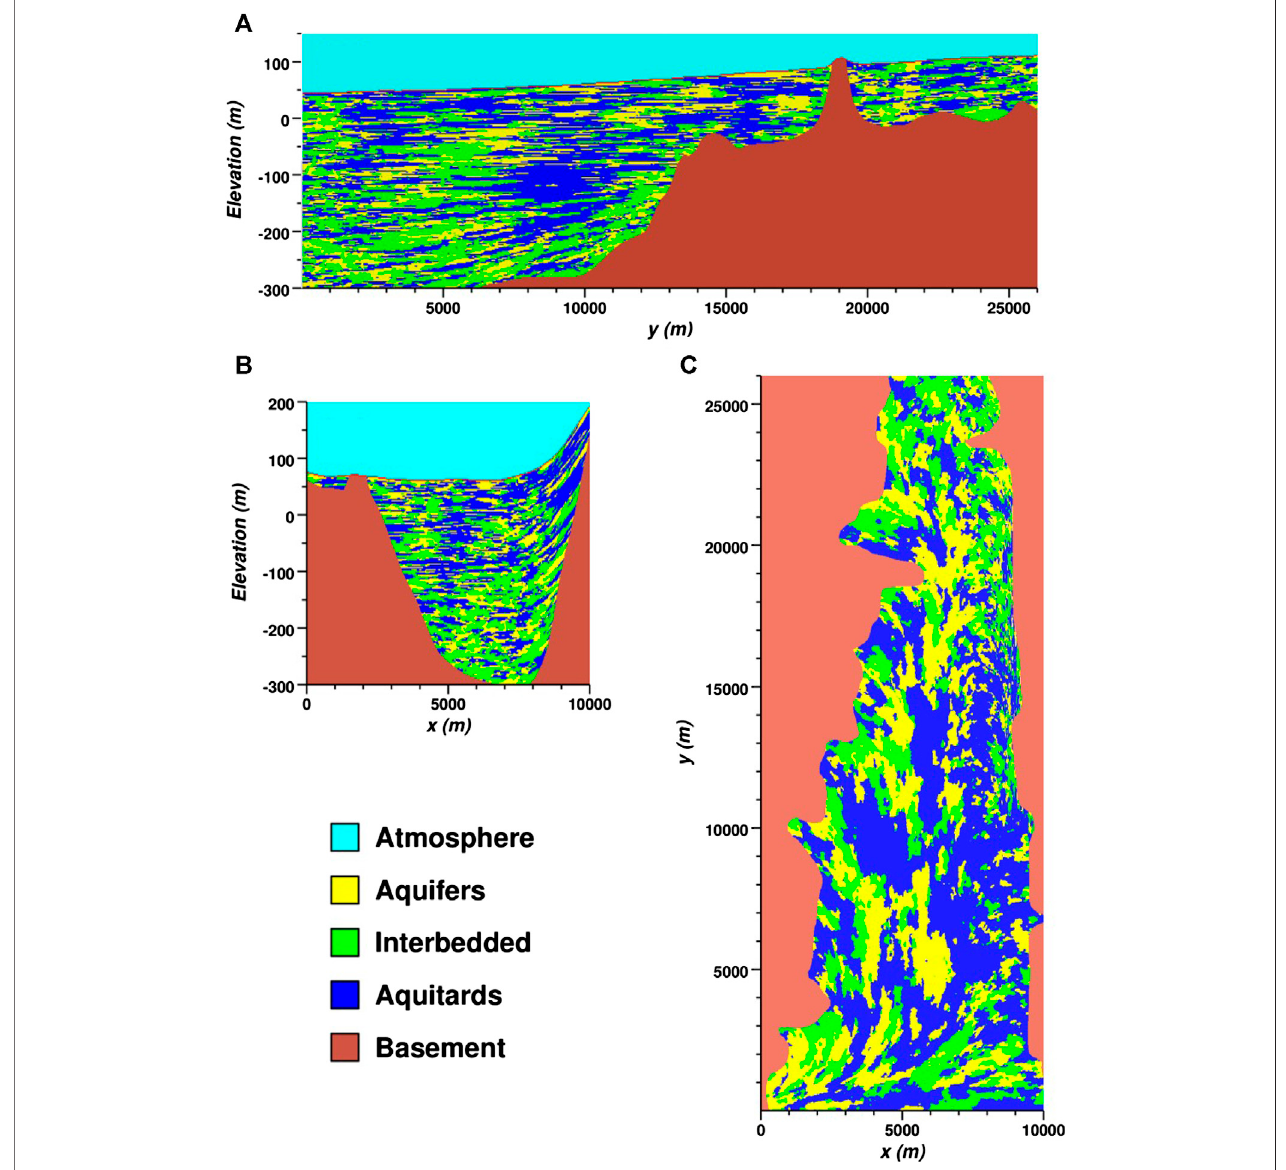
FIGURE 9 | Cross-section through the 3-D simulation shown in Figure 8 throught (A) longitudinal (B) lateral, and (C) horizontal planes.